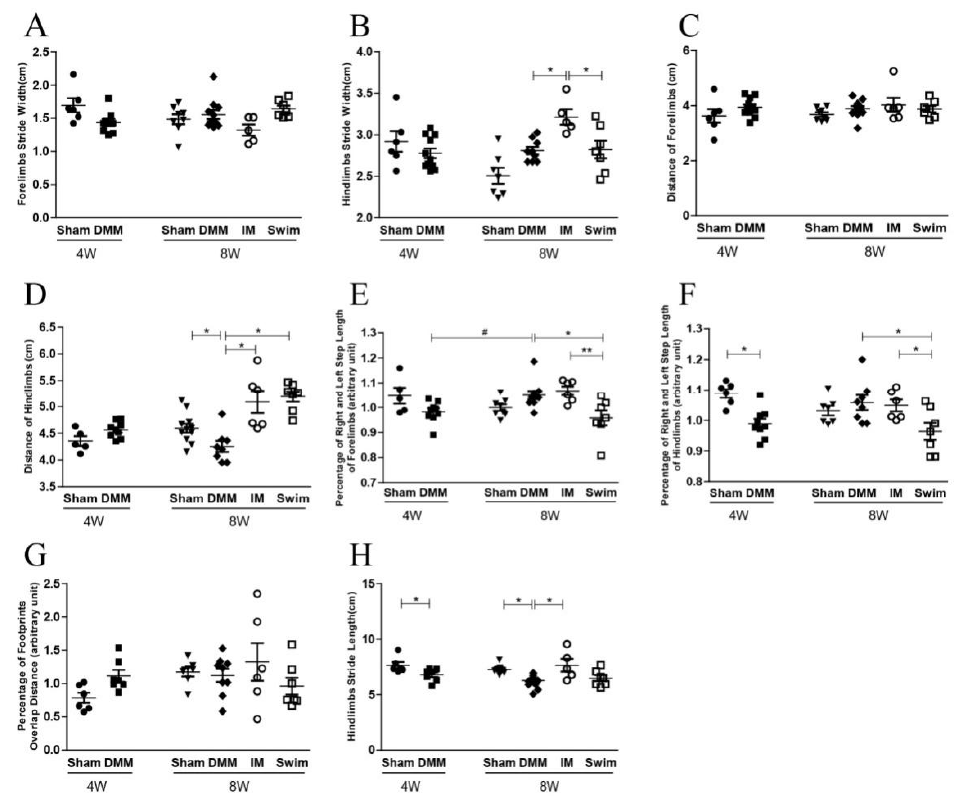
Figure 1. Ink blot analysis showing the effects of swimming and immobilization on the progression of OA at the middle stage. ( A ) Forelimb stride width; ( B ) hindlimb stride width; ( C ) distance of forelimbs; ( D ) distance of hindlimbs; ( E ) percentage of right and left step length of forelimbs; ( F ) percentage of right and left step length of hindlimbs; ( G ) percentage of footprint overlap distance; ( H ) hindlimb stride length. 4W: the time point of starting swimming or immobilization, which is 4 weeks after DMM surgery. 8W: the time point after 4 weeks of swimming and immobilization, which is 8 weeks after DMM surgery. IM, immobilization; DMM, destabilization of the medial meniscus; * p < 0.05, ** p < 0.01, # p <0.05 (difference between 4W and 8W after DMM), n ≥